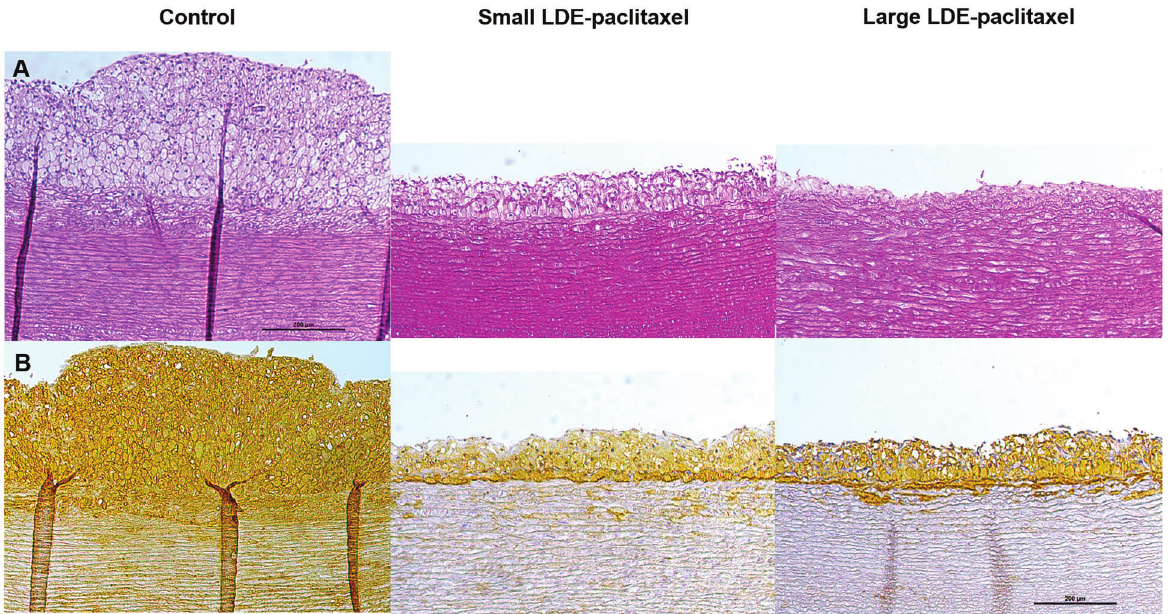
Figure 3. A , Representative photomicrographs of aortic arch stained by hematoxylin-eosin of control, small lipid nanoparticles (LDE)- paclitaxel and large LDE-paclitaxel groups. B , Immunohistochemistry of macrophage stained area on artery tissues from the three groups. Brown staining indicates macrophages stained by DAB chromogen. Magni fi cation: 100 (cid:2) . Bar: 200 m m.